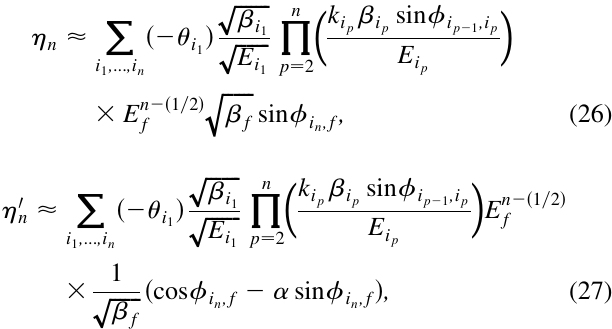
ffiffiffiffiffiffiffi p (cid:6) i 1